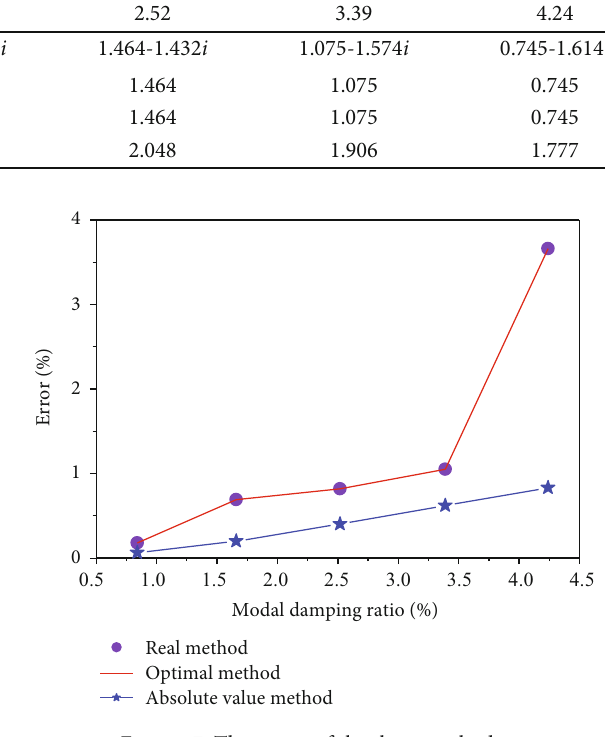
Figure 7: The errors of the three